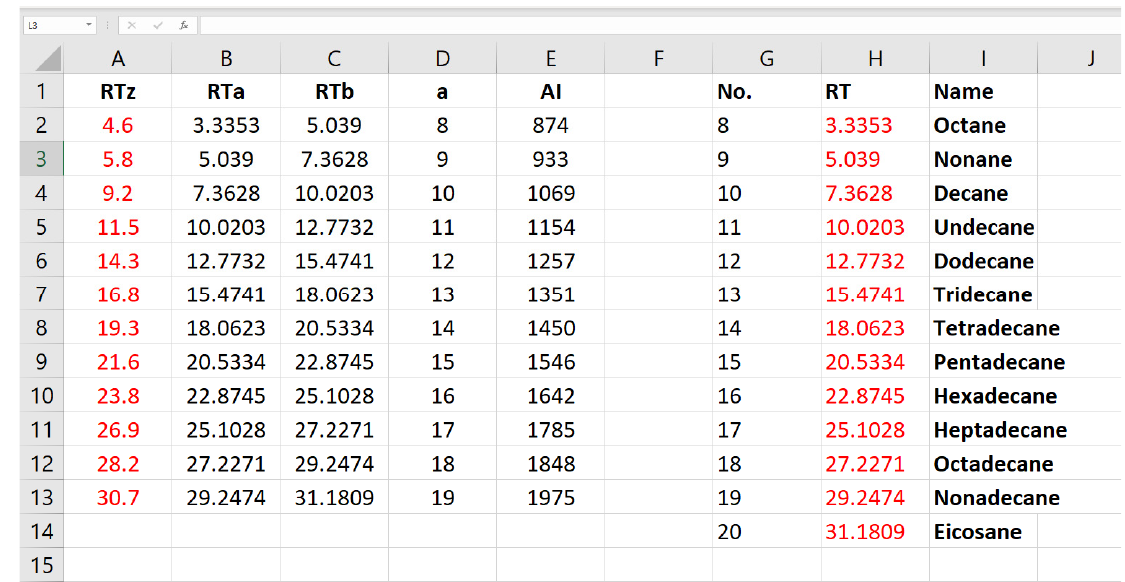
Figure 20. Excel spreadsheet for automatic calculation of arithmetic index by cutting and pasting of RT values (cells A2–A13). RTz is the retention time of the essential oil component, RTa is the retention time of the n-alkane that elutes before RTz, RTb is the retention time of the n-alkane that elutes after RTz, a is the carbon number of the n-alkane that elutes before RTz, AI is the calculated arithmetic index. Rows G–I are information of the retention times of the homologous series of n-alkanes. Table 2. Calculations used on the excel spreadsheet in Figure 20 for automatic calculation of arithmetic index.